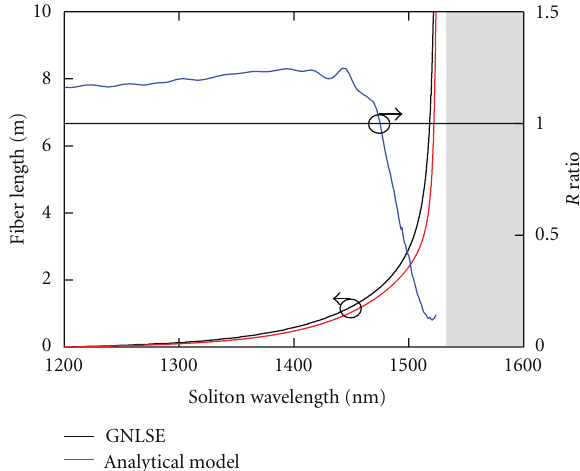
Figure 7: Left axis: evolution of the soliton central wavelength with fiber length calculated by integration of the GNLSE (black line) and with (5) in the case of the Gordon model (red line). Right axis: evolution of the R ratio defined by (8) with soliton